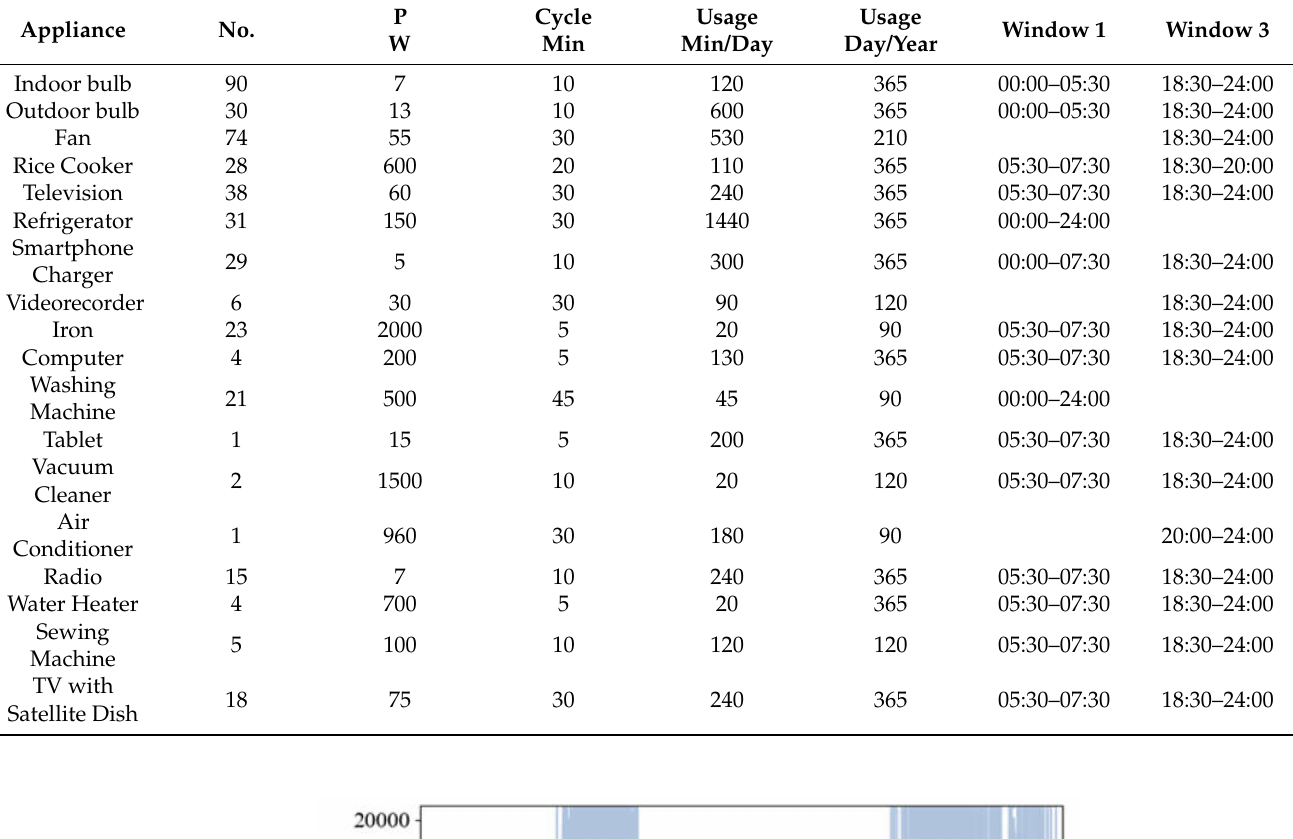
Table 1. Electricity demand profile of the model community, based on [40–42] and own assumptions.